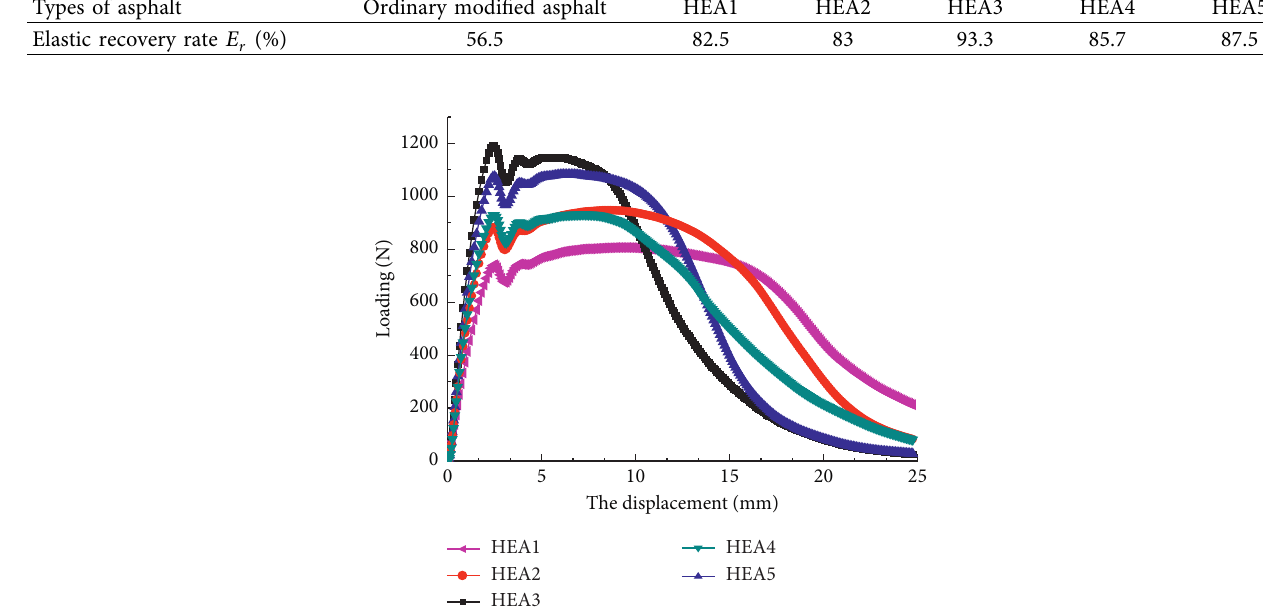
Figure 7: Impact toughness curve of asphalt with different asphalt binders.